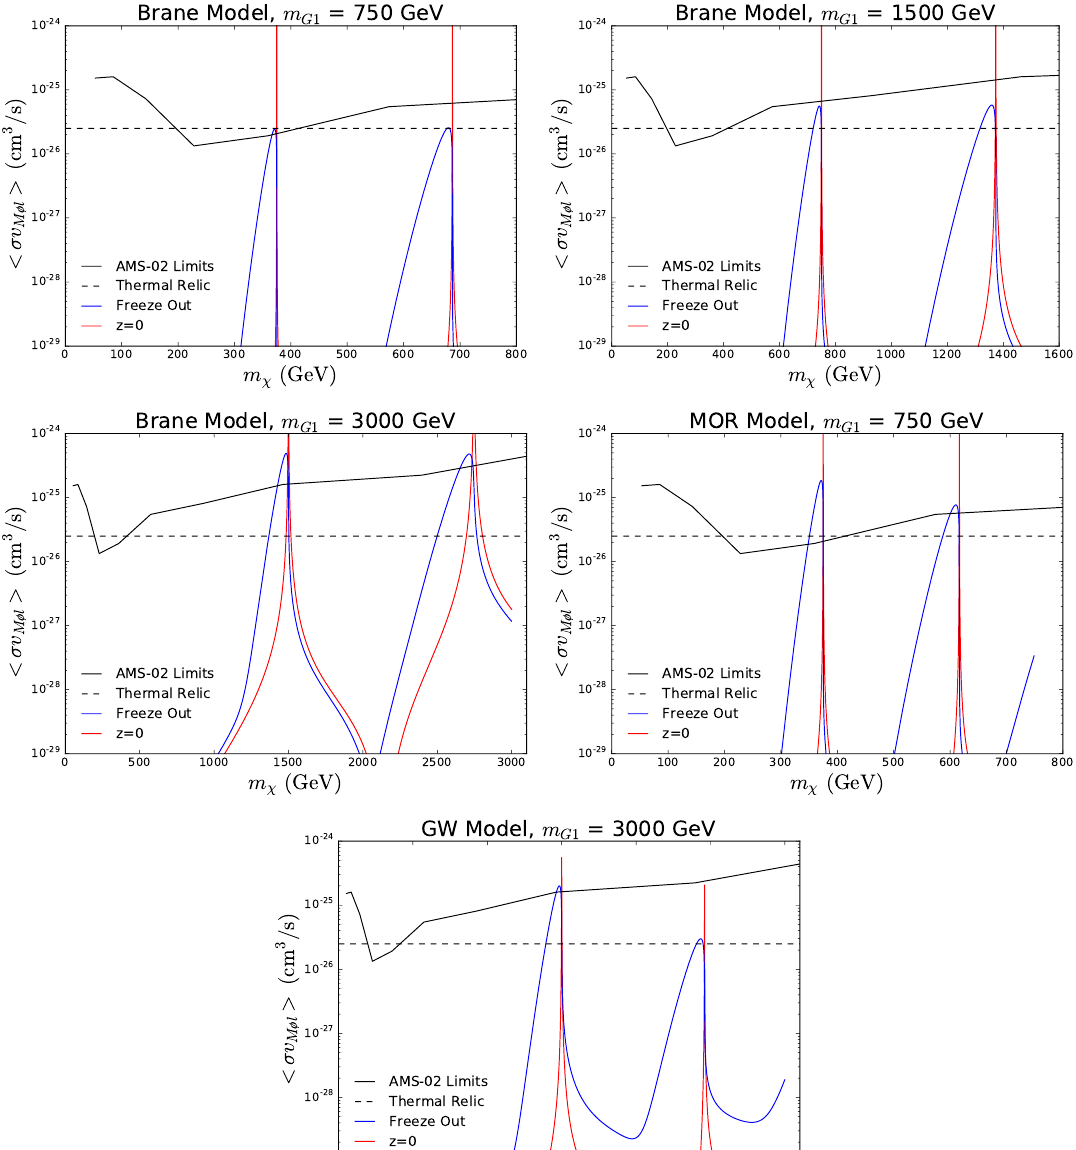
Figure 8 . The thermally averaged annihilation cross sections for spin-1 dark matter annihilating into p (cid:22) p at z=0 (red) and at freeze-out (blue) in the 5 benchmark models as a function of the DM mass. The AMS-02 antiproton constraints correspond to the black curve, while the value of h (cid:27)v i that achieves the observed relic abundance is shown as the dashed black curve as a guide for allowed DM